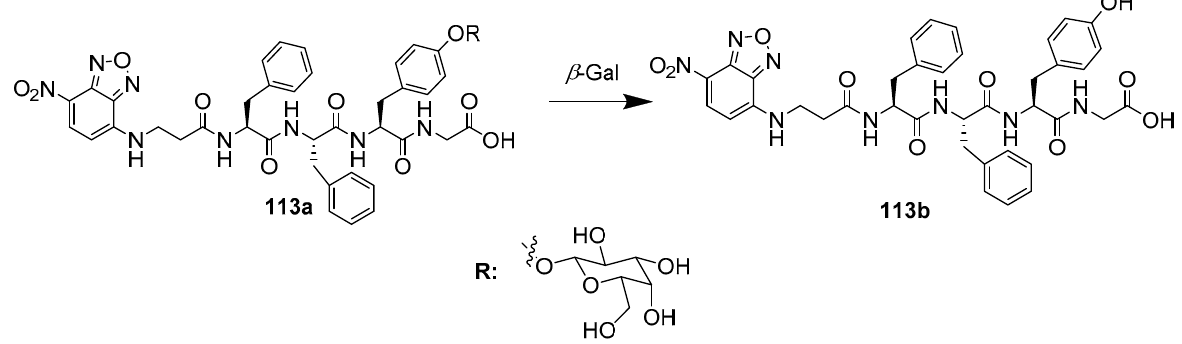
Figure 66. Gelator precursor for β -galactosidase [119].